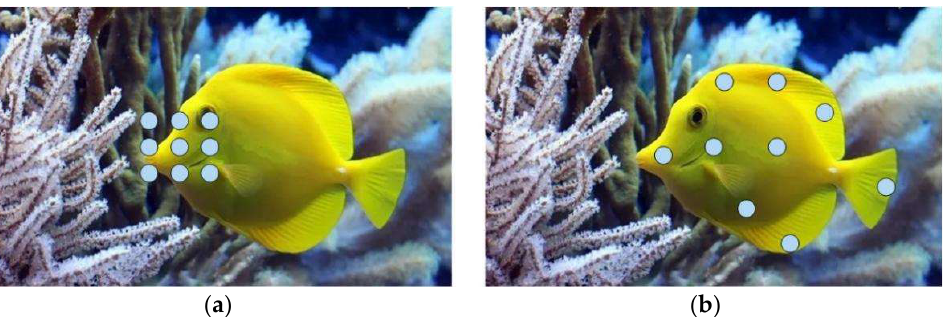
Figure 11. Standard convolution and deformable convolution: ( a ) is standard convolution and ( b ) is deformable convolution. The circle in the figure represents the change of the convolution range.